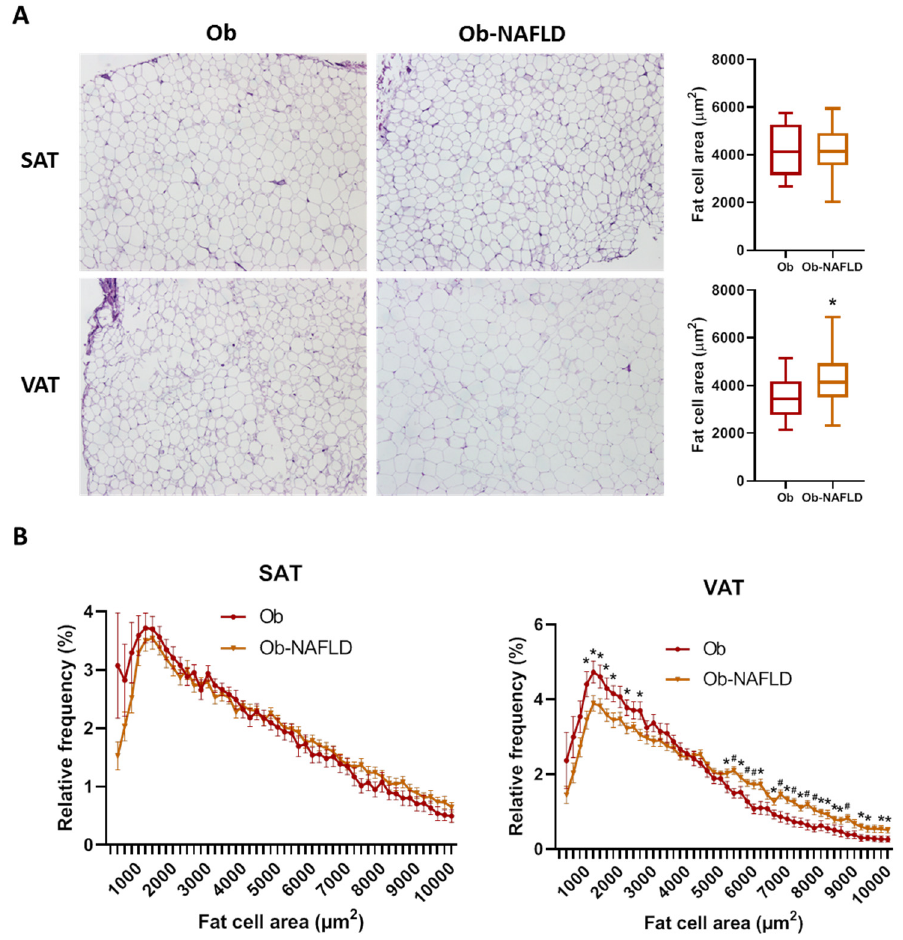
Figure 1. Fat cell size distribution. ( A ) Comparison of adipocyte mean cell surface area and representative images of SAT and VAT samples from Ob and Ob-NAFLD individuals. ( B ) Frequency distribution analysis of fat cell areas divided by size into bin intervals of 200 µ m 2 . Data are presented as mean ± SD frequencies of cells within each bin and compared by Mann-Whitney U test. SAT, subcutaneous adipose tissue; VAT, visceral adipose tissue. *= p < 0.05, # = p < 0.01.